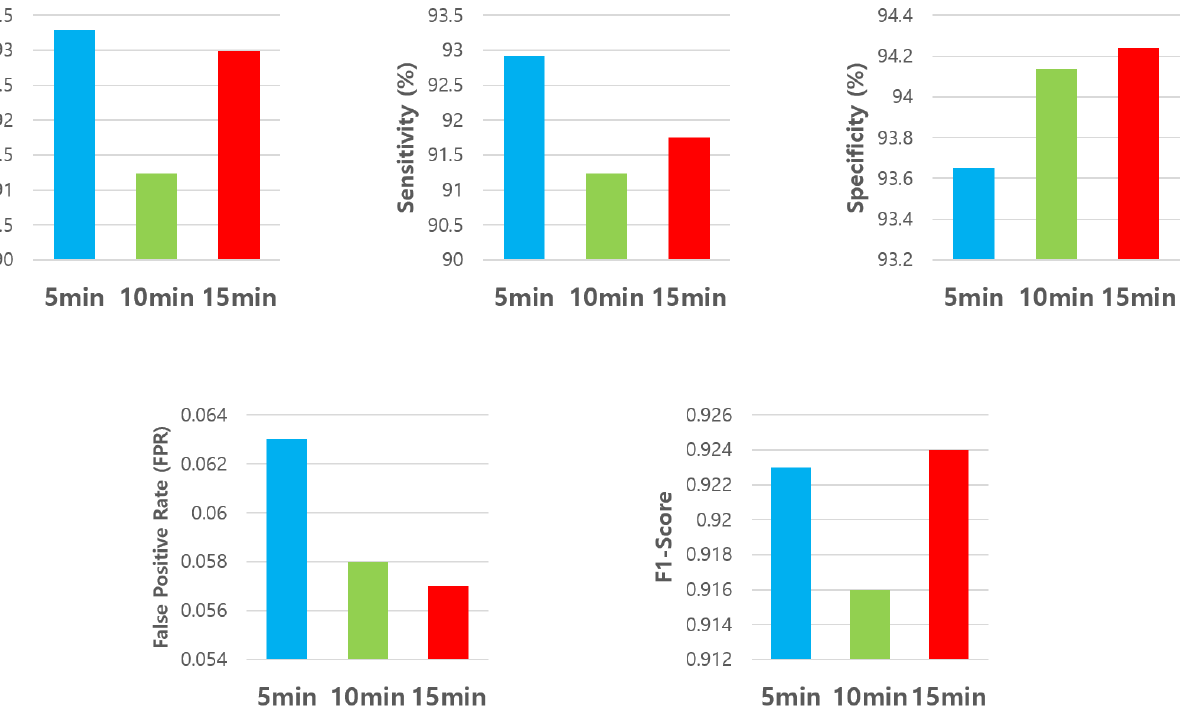
Figure 9. Average of accuracy, sensitivity, specificity, false positive rate and F1-score according to preictal lengths of 5, 10, 15